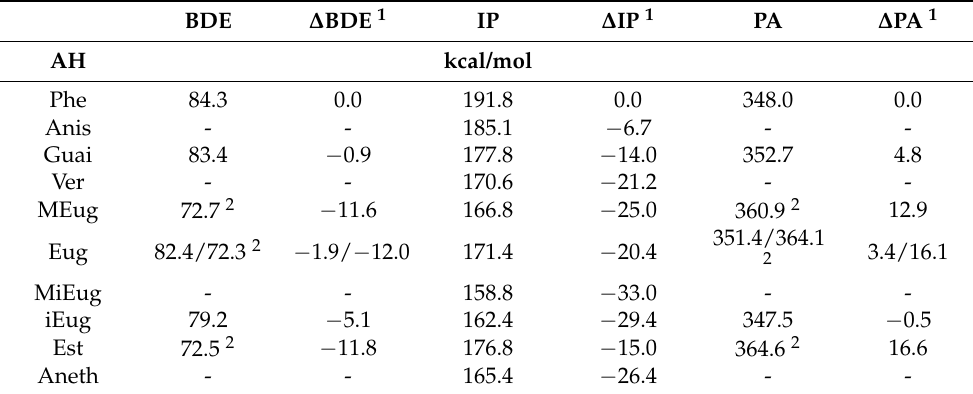
Table 1. Absolute and relative ( ∆ ) BDE, ( ∆ ) ionization potential (IP), and ( ∆ ) proton affinity (PA) values (kcal/mol) of the test compounds in the gas phase at B3LYP/6-31G//B3LYP/6-311++(2d,2p) level. BDE ∆ BDE